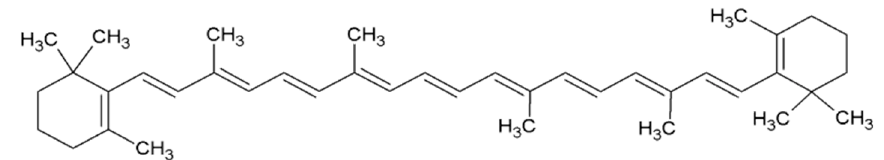
Figure 2. The structural formula of β -carotene.